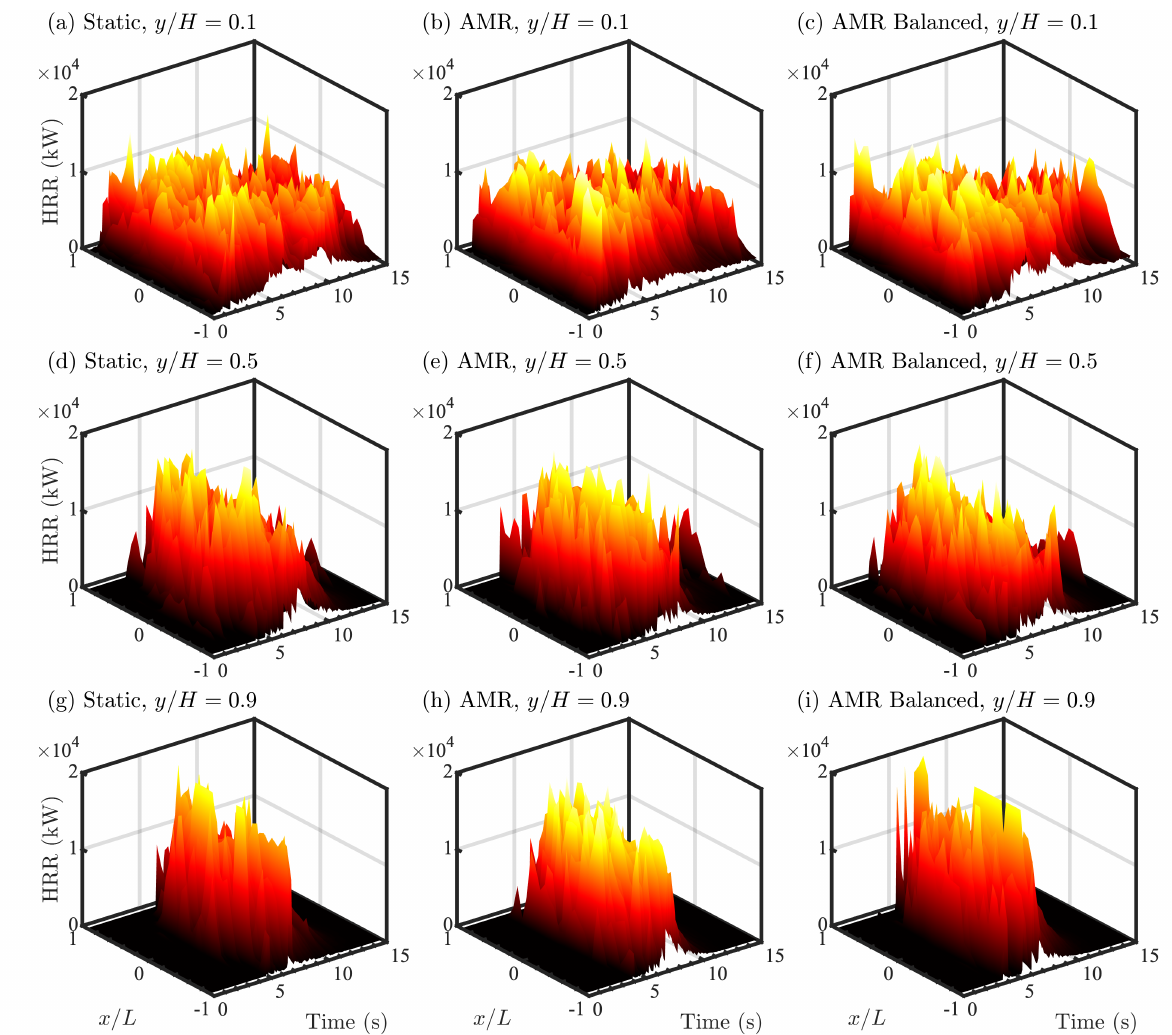
Figure 7. Time histories of gas-phase modeled HRR across the panel, near the gas–solid interface, for the single panel vertical fire spread verification test case. Rows from top to bottom show time histories at panel heights of z / H = 0.1, 0.5, and 0.9, where H = 2.4 m is the total height and columns from left to right correspond to static, AMR, and balanced AMR cases, respectively. Temperatures are colored from low (black) to high (yellow). The transverse location x is normalized by the half panel width L = 0.3 m in all